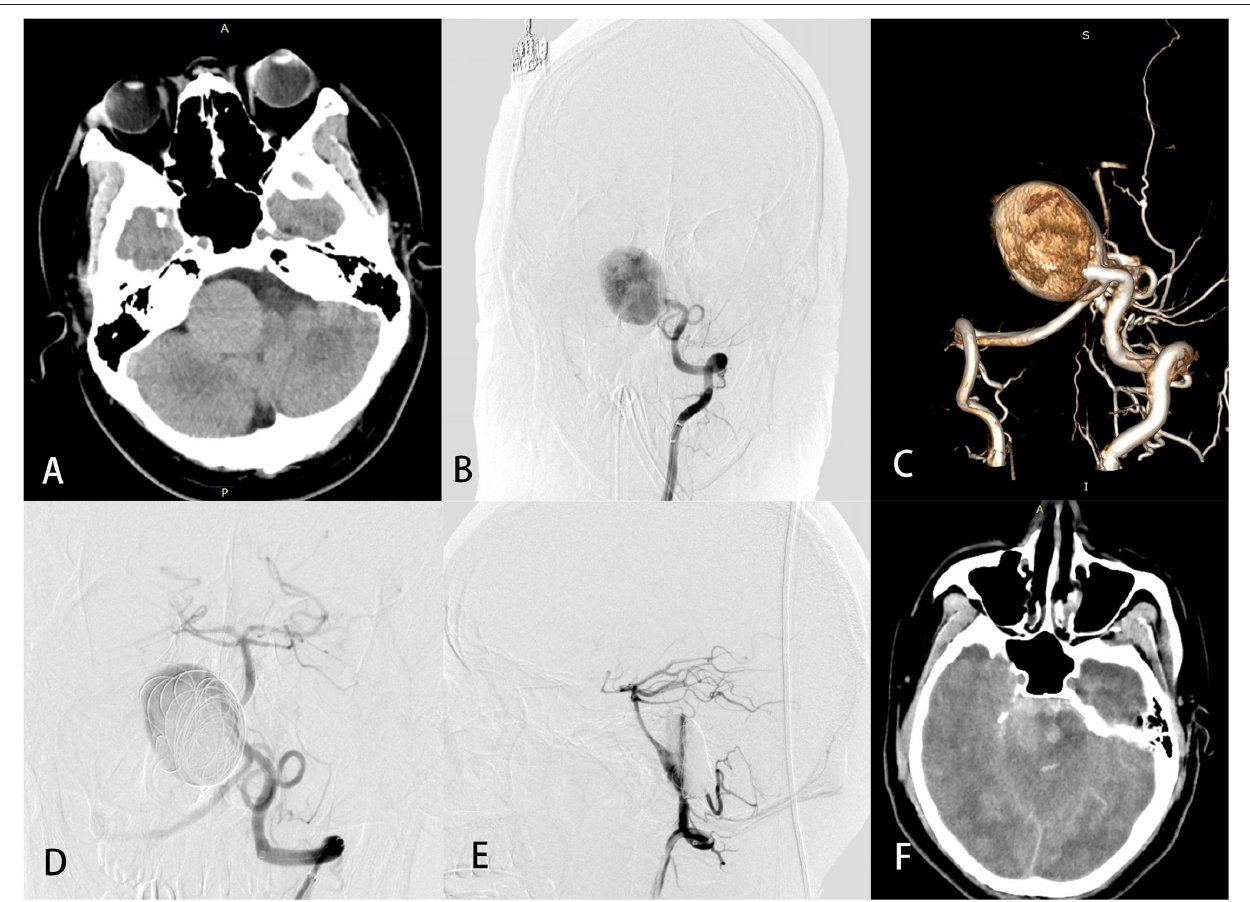
FIGURE 3 | A 26-year-old man (case 29) with a giant basilar artery aneurysm presented with tinnitus. Preoperative computed tomography (A) showed a large mass in the right anterior brainstem. Preoperative angiography (B) with 3-dimensional reconstruction (C) showed a giant side wall saccular aneurysm of the proximal basilar artery. Anteroposterior (D) and lateral (E) views of left vertebral angiography demonstrated excellent reconstruction of the basilar artery and contrast stasis in the lumen of the aneurysm. Computed tomography (F) on postprocedure day 3 was obtained to evaluate headache, vomiting, and disturbed consciousness and revealed massive subarachnoid hemorrhage. The patient later